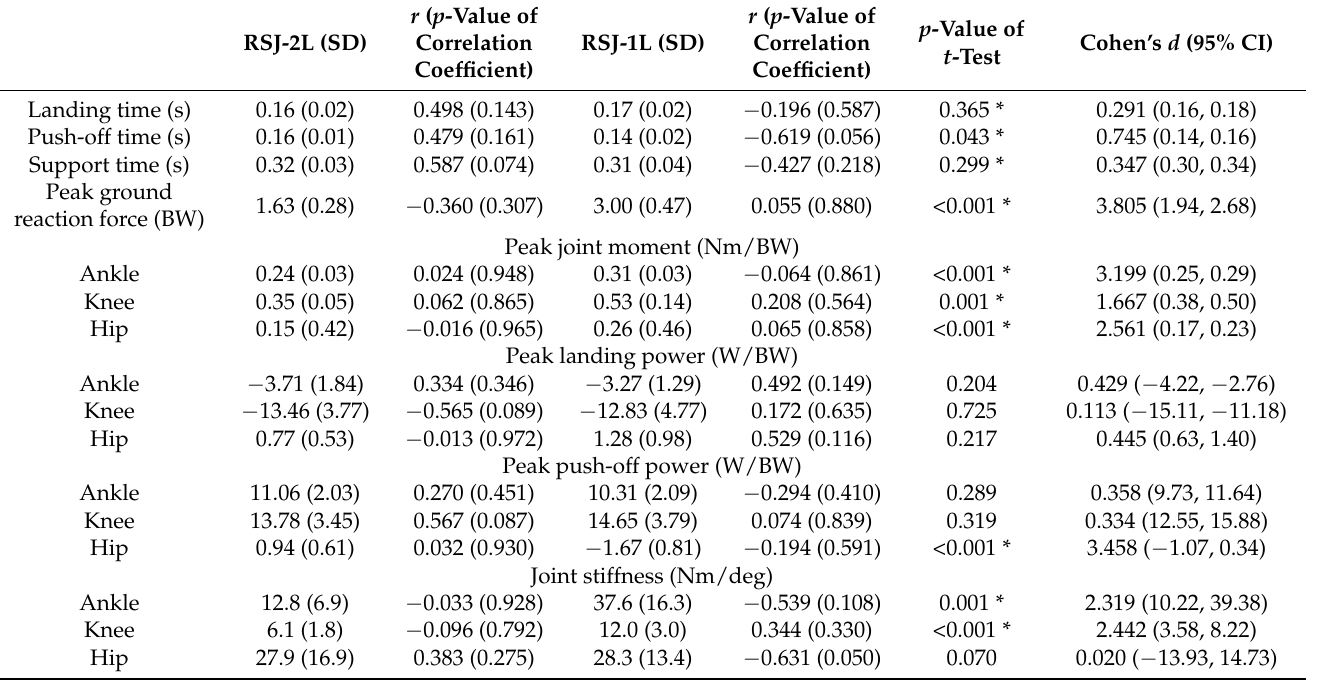
* Indicates significant difference found between the RSJ-1L and RSJ-2L, p < 0.05. r : correlation coefficient of jump height. The positive value of power represents power generation, while the negative value of power represents power